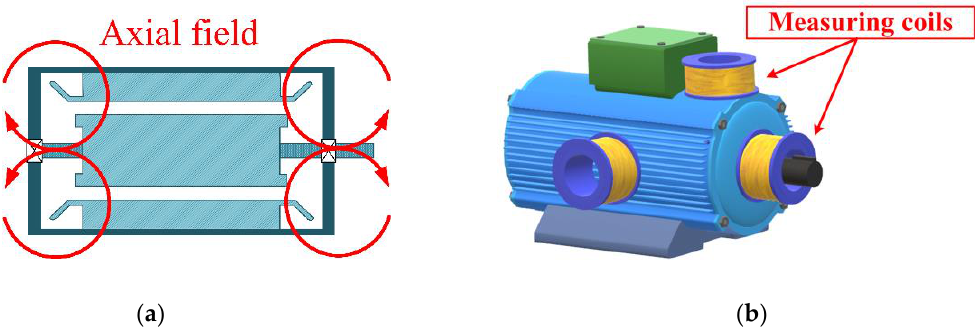
Figure 1. External stray (axial) flux in a squirrel cage induction motor ( a ) and method of possible placement used for the axial flux measuring coils ( b ).